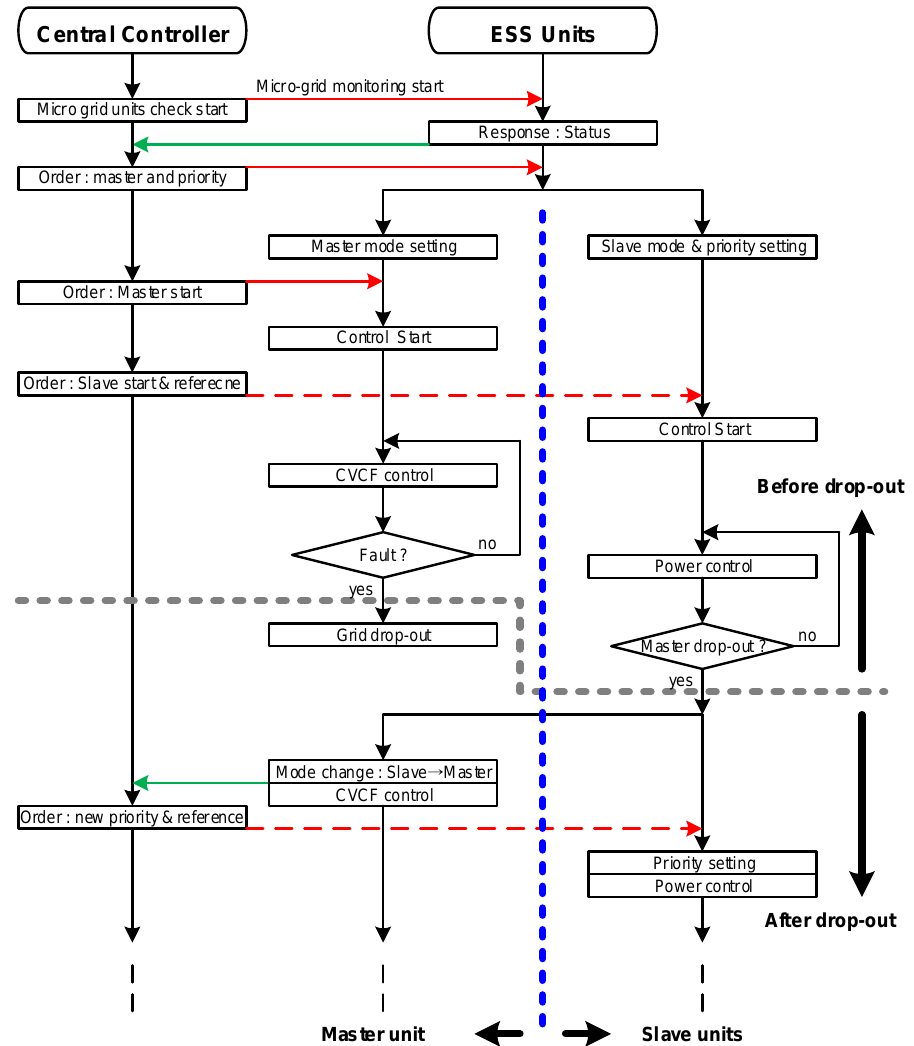
Figure 3. Control sequence of the proposed control method.